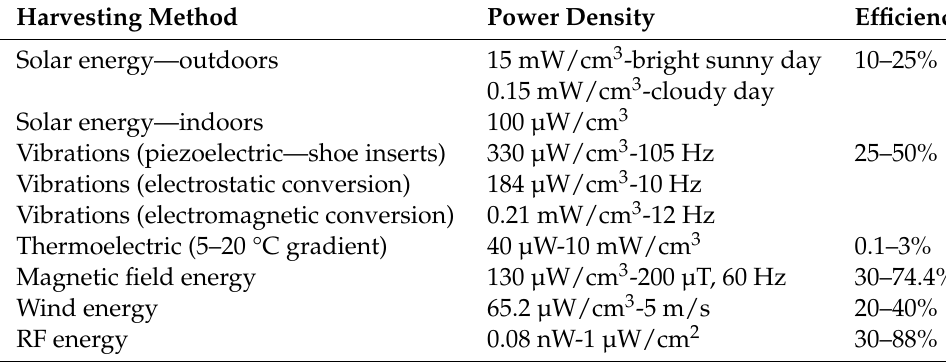
Table 1. Renewable energy sources along with their power densities and efficiency.